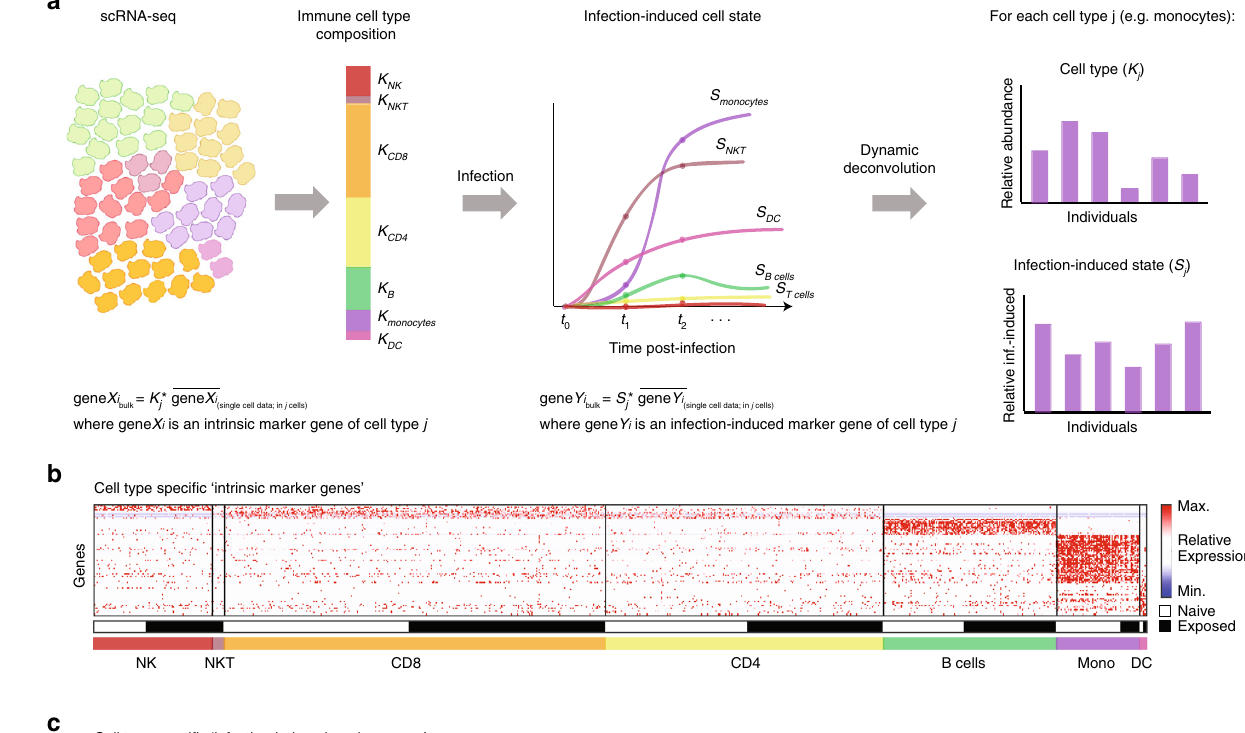
ExposedMin.Max. Relative